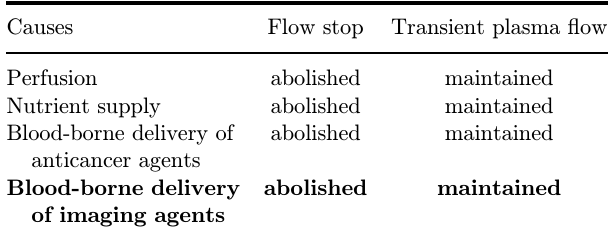
Table 3. Subtypes of acute hypoxia according to causative mechanisms and associated blood-borne transport capacities.